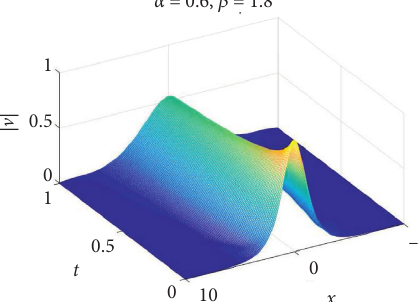
Figure 11: The trace of the solution to | v | of FCNLSE (32) with α � 0 . 8 and β � 1 . 2.